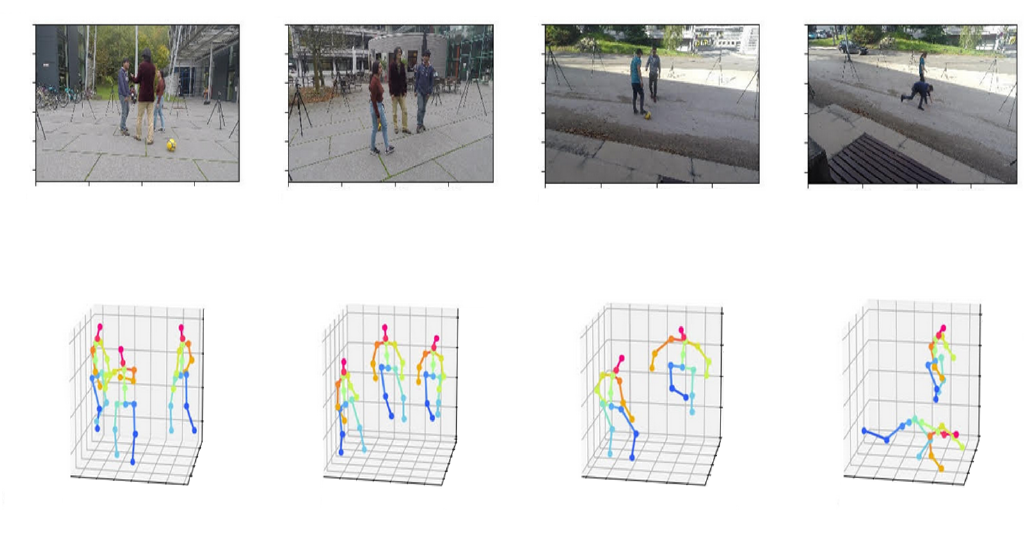
Figure 2. Examples of 3D absolute poses resulting from our whole